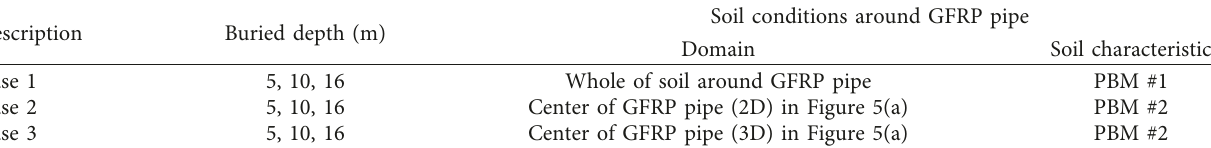
Table 3: Soil conditions around GFRP pipe for the finite-difference analysis [9].